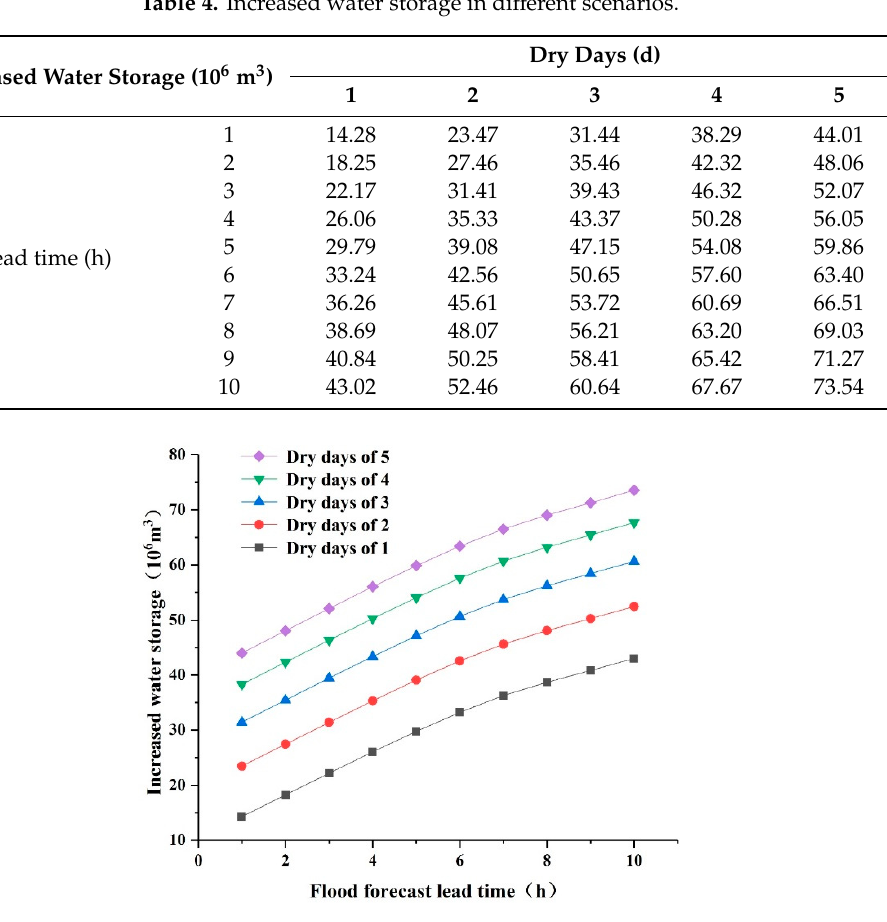
Figure 7. Statistical chart of floodwater volume over the flood limited water level (FLWL) in different scenarios.